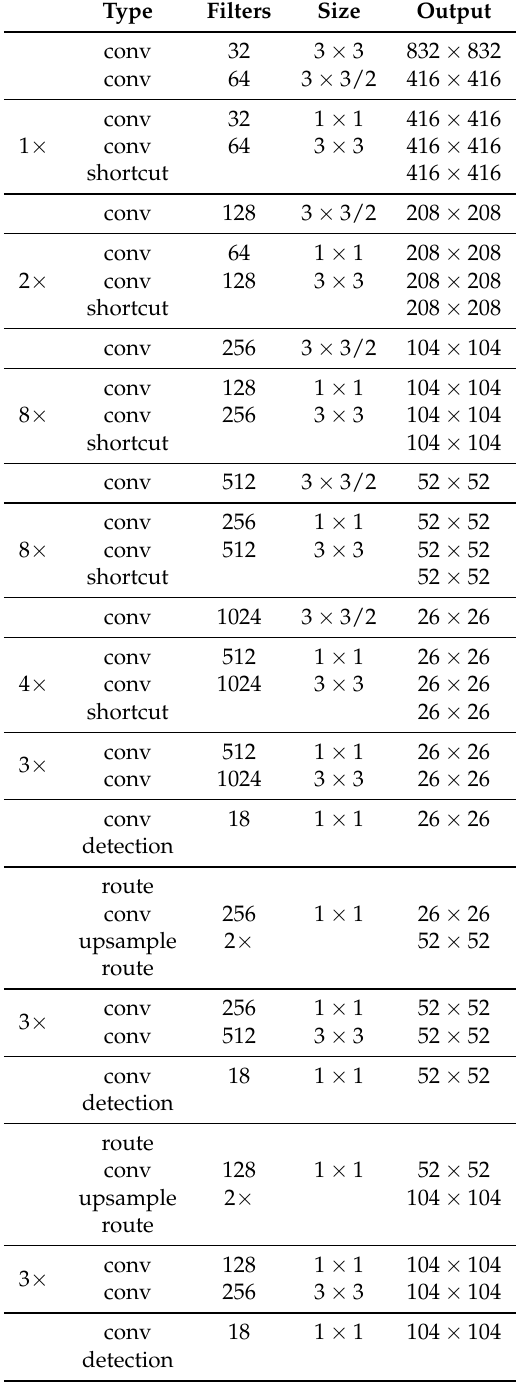
Table 1. The structure of the YOLOv3